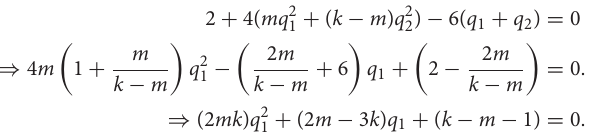
Therefore, for each pair 1 i , j k , either p i ≤ ≤ . . . (2 6( p i p j ) 4( p 2 p 2 )) 0. If both of the pairs p i , p j 1 + k − + + + =